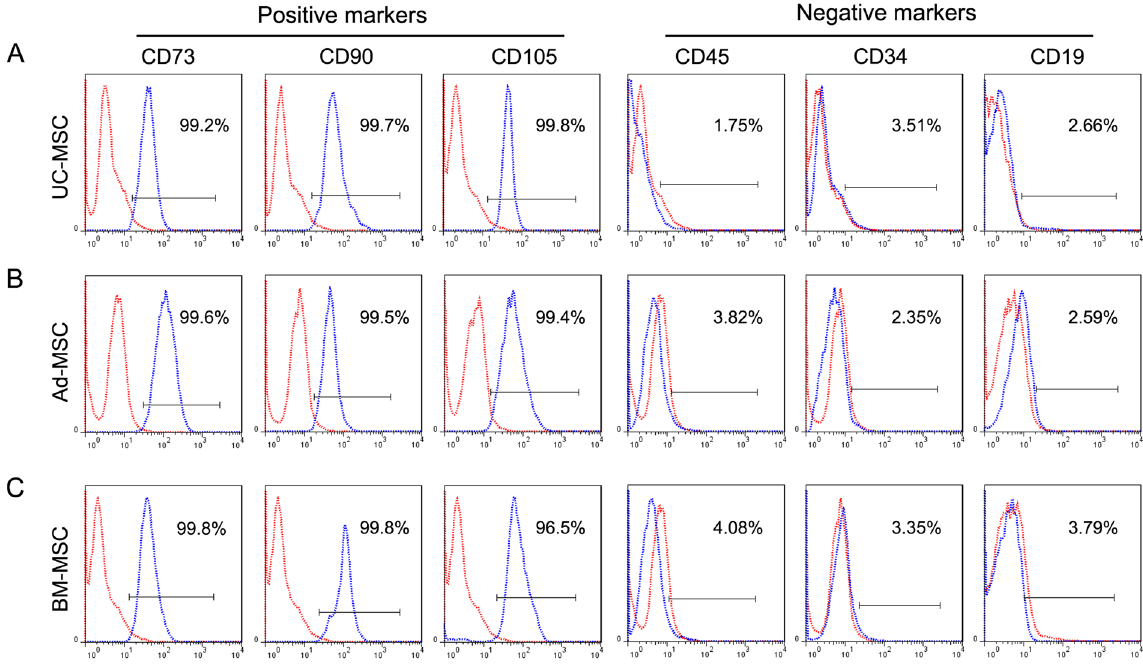
Figure 2. Immunophenotype of MSCs. UC-MSC ( A ), Ad-MSC ( B ) and BM-MSC ( C ) were labeled with antibodies against the indicated antigens, and analyzed by flow cytometry. The markers CD73, CD90 and CD105 showed highly positive expression and the markers CD45, CD34 and CD19 showed negative expression, consistent with the characteristic pattern of mesenchymal surface markers.